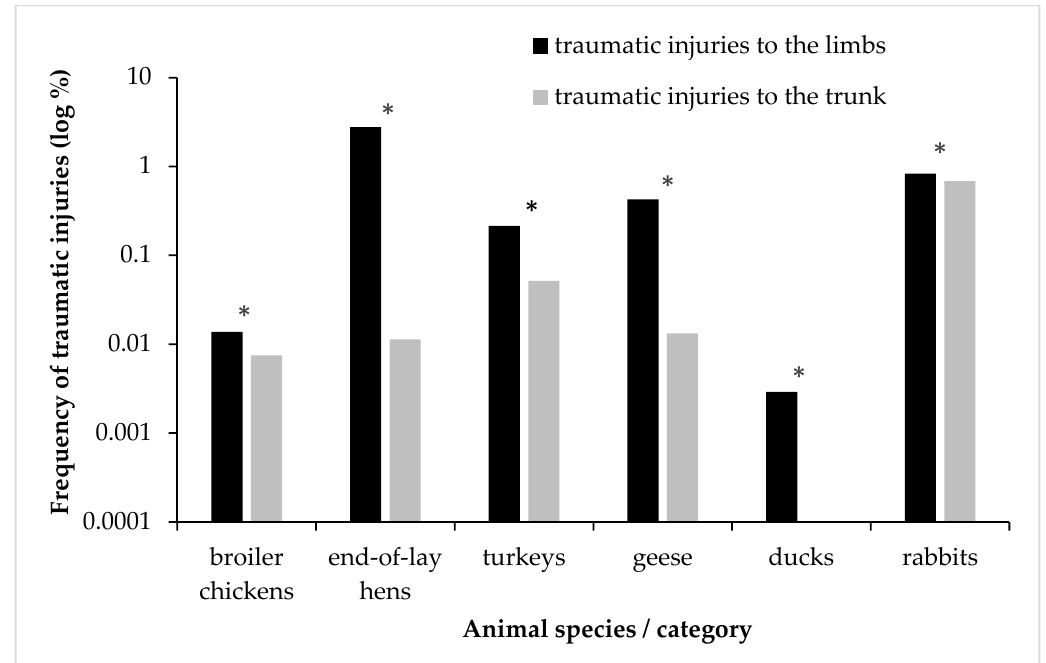
Figure 1. Comparison of frequency (log %) of traumatic injuries to limbs and trunk in different species and categories of poultry and rabbits. * statistically significant difference between frequency of traumatic injuries to the limbs and to the trunk in the given species/category ( p < 0.01).